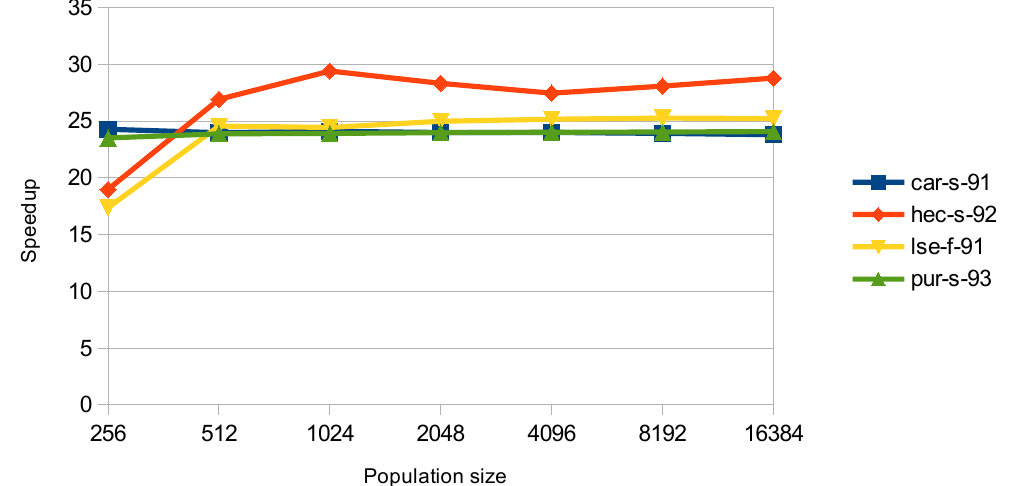
Figure 7. Speedup in the greedy steepest descent algorithm